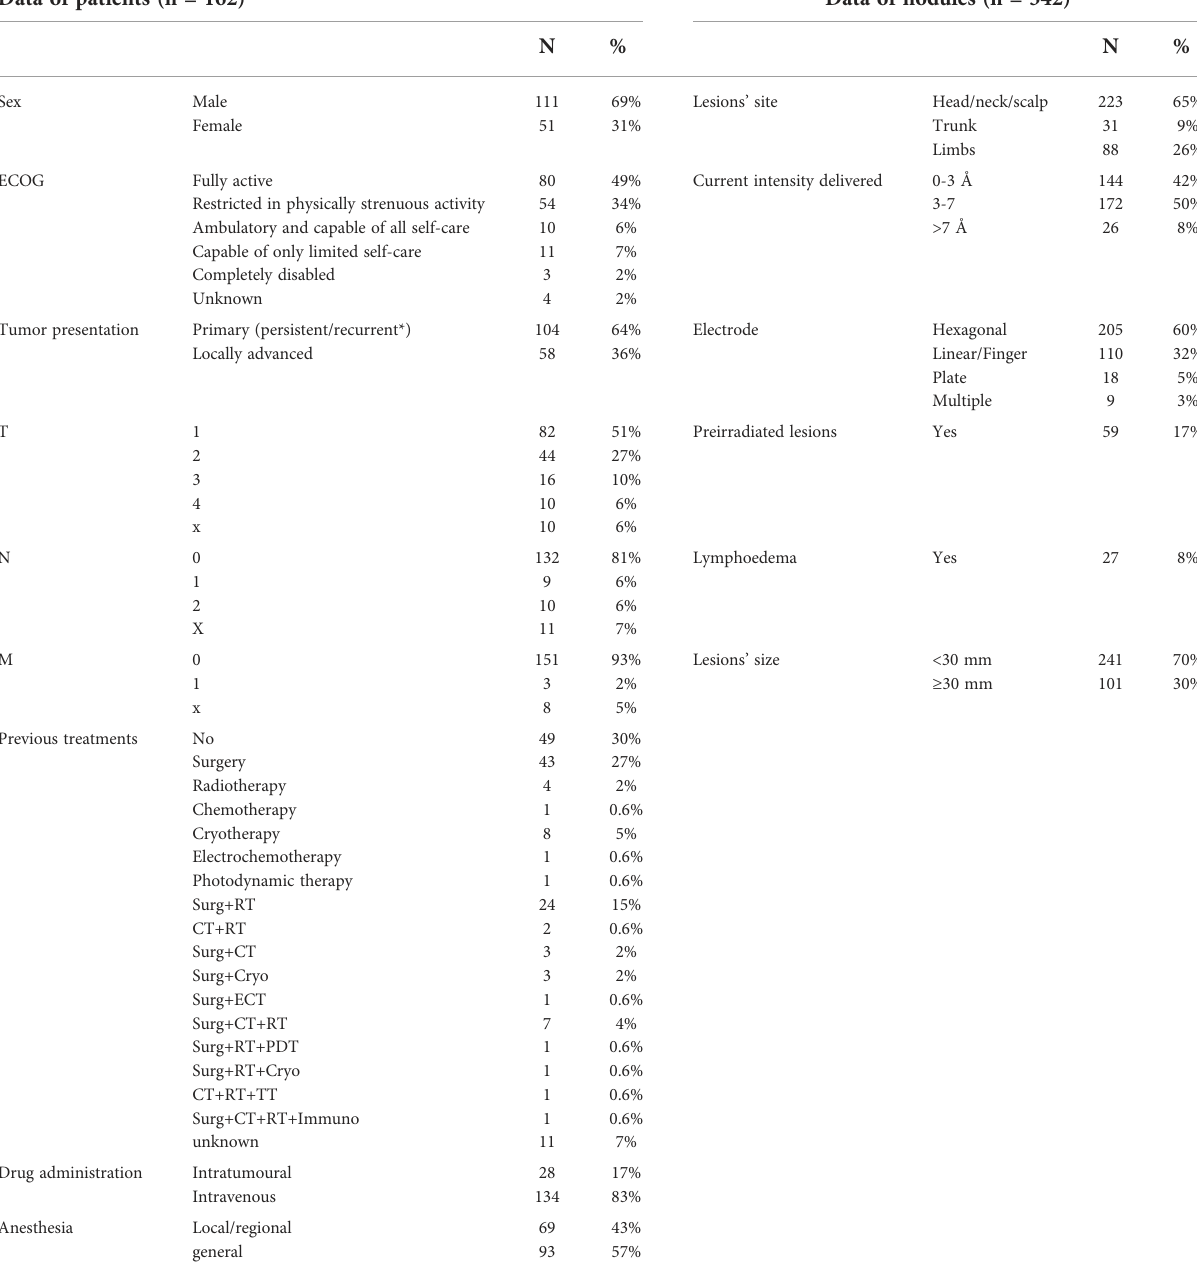
TABLE 1 Characteristics of the cohort of patients, nodules and treatment characteristics. Data of patients (n =